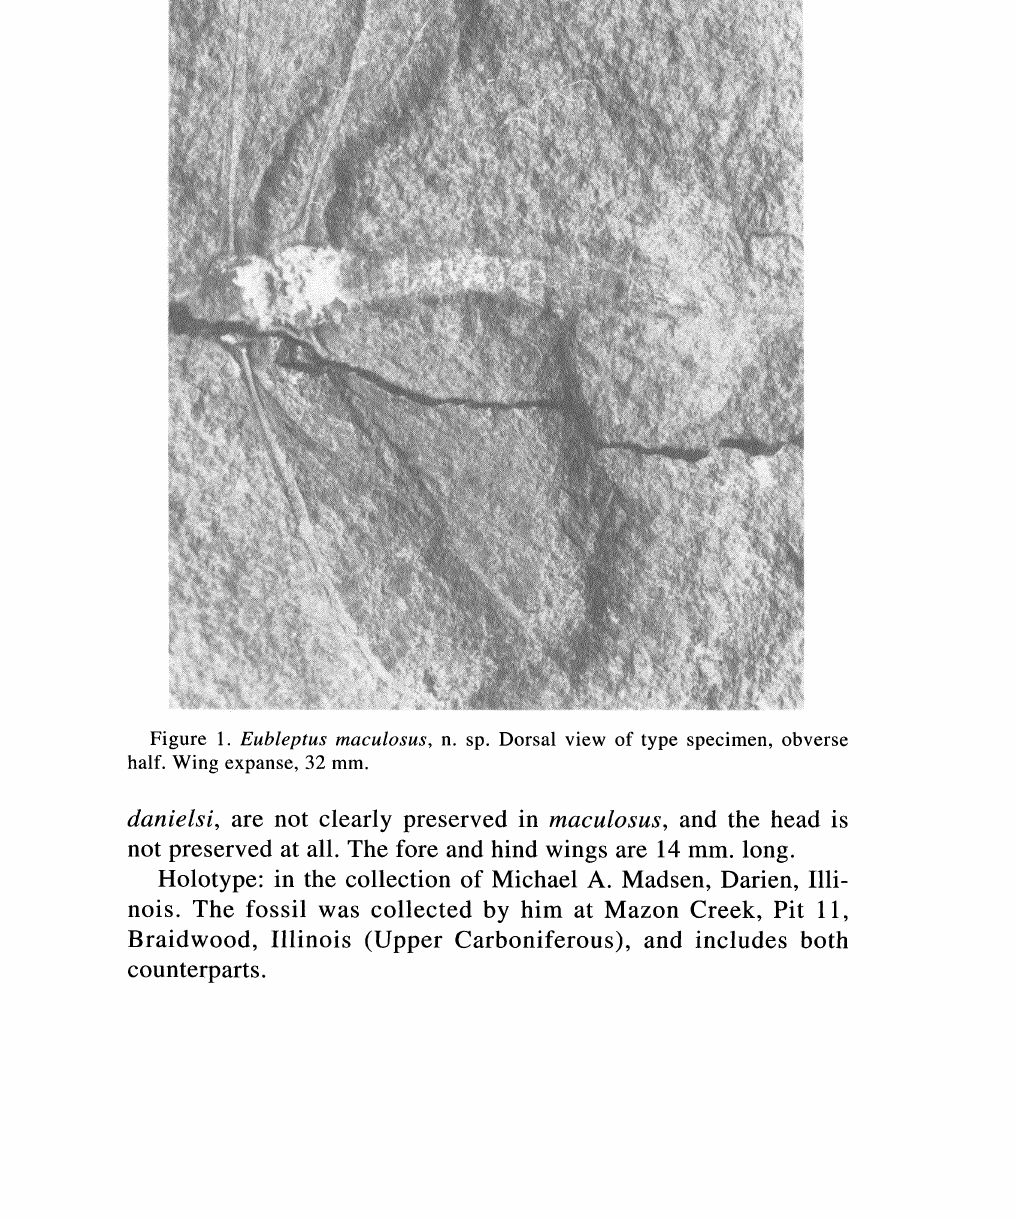
Braidwood, Illinois (Upper Carboniferous), and includes both